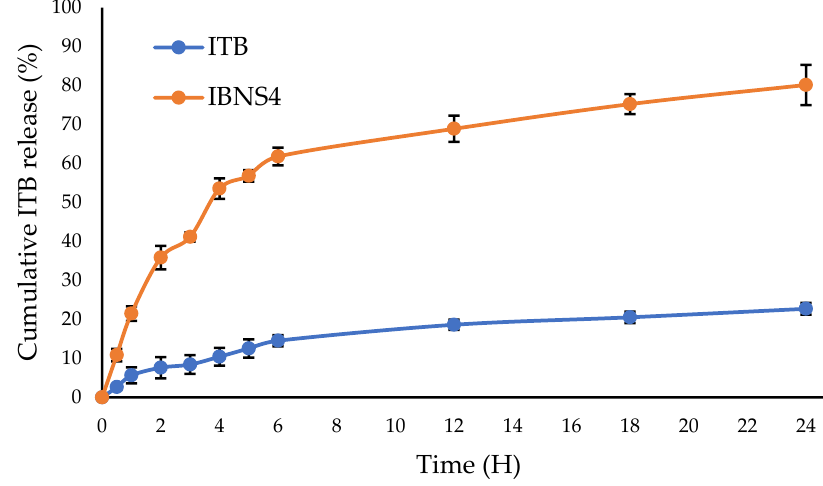
Figure 7. Cumulative (%) release of ITB and IBNS4.